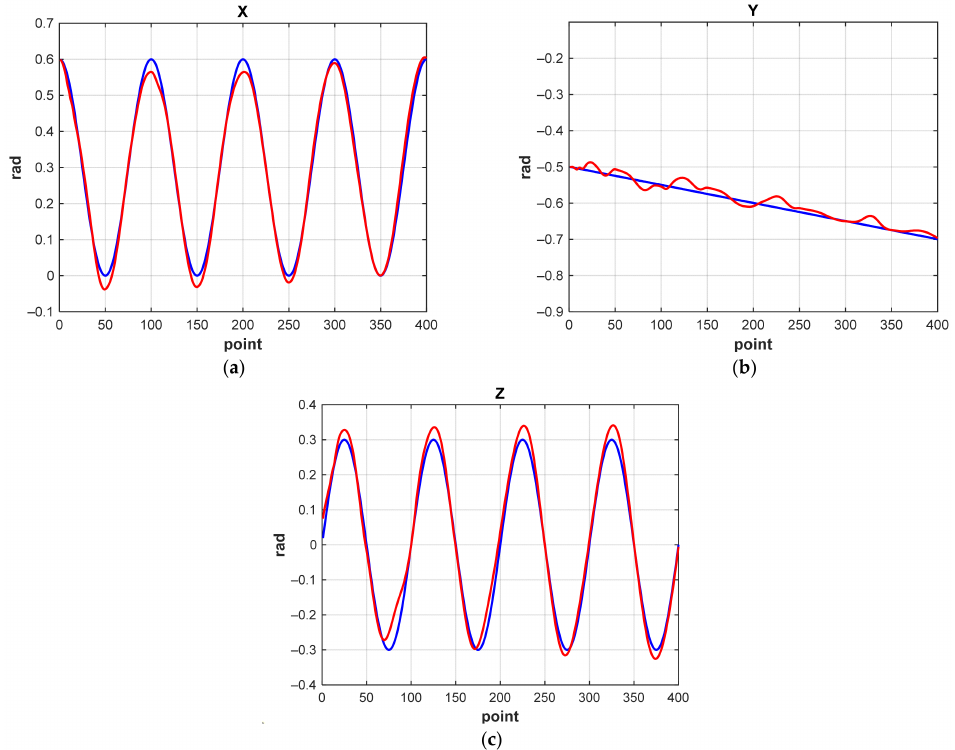
Figure 19. Graphs of changes in coordinates when the manipulator moves in a 3D spiral (MATRIX NN 1): ( a ) along the X-axis; ( b ) along the Y-axis; ( c ) along the Z-axis.